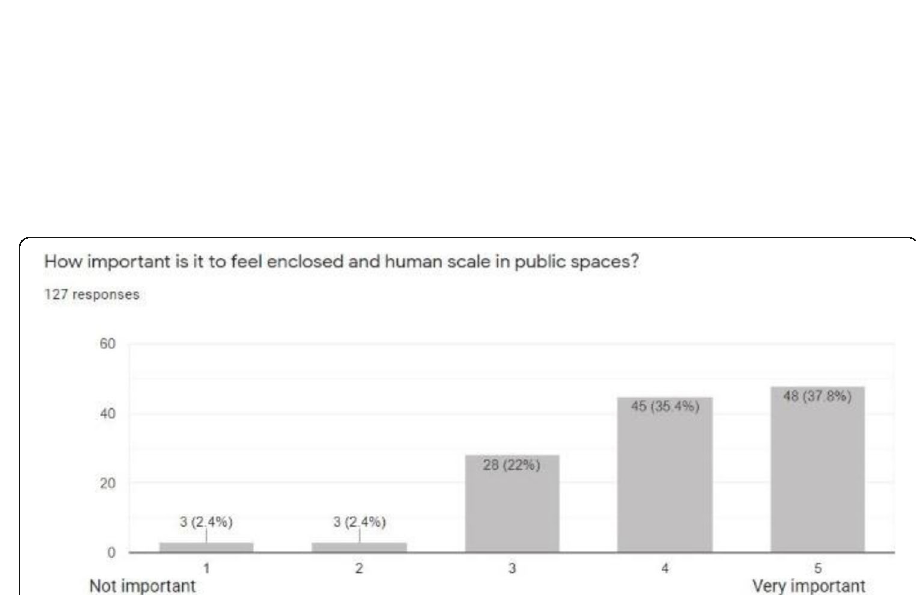
Fig. 25 Importance of enjoying place aesthetics (Author)